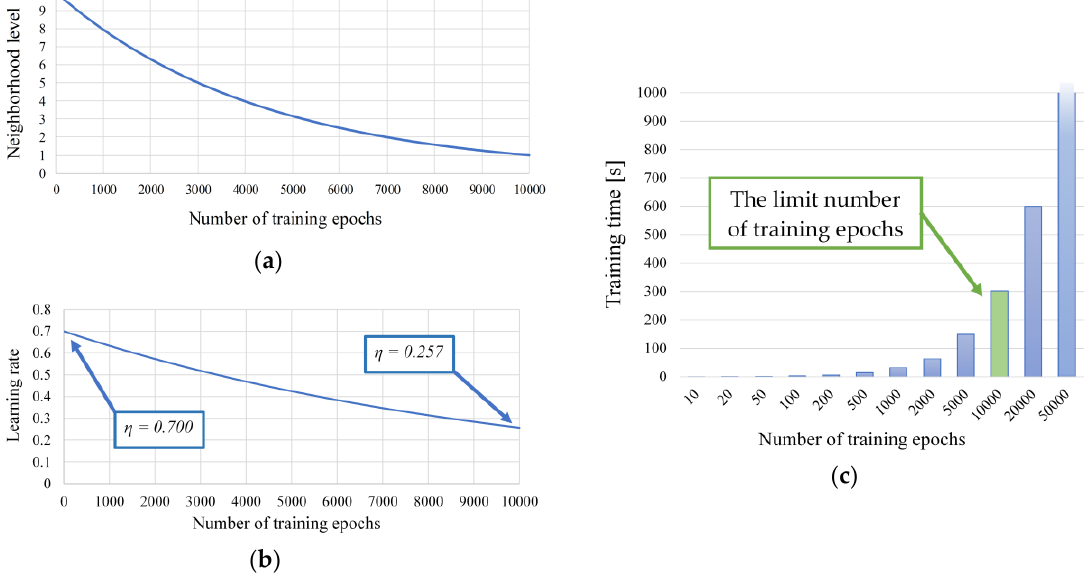
Figure 6. Training parameters of the SOM network: ( a ) neighborhood level; ( b ) learning rate; ( c ) learning time.